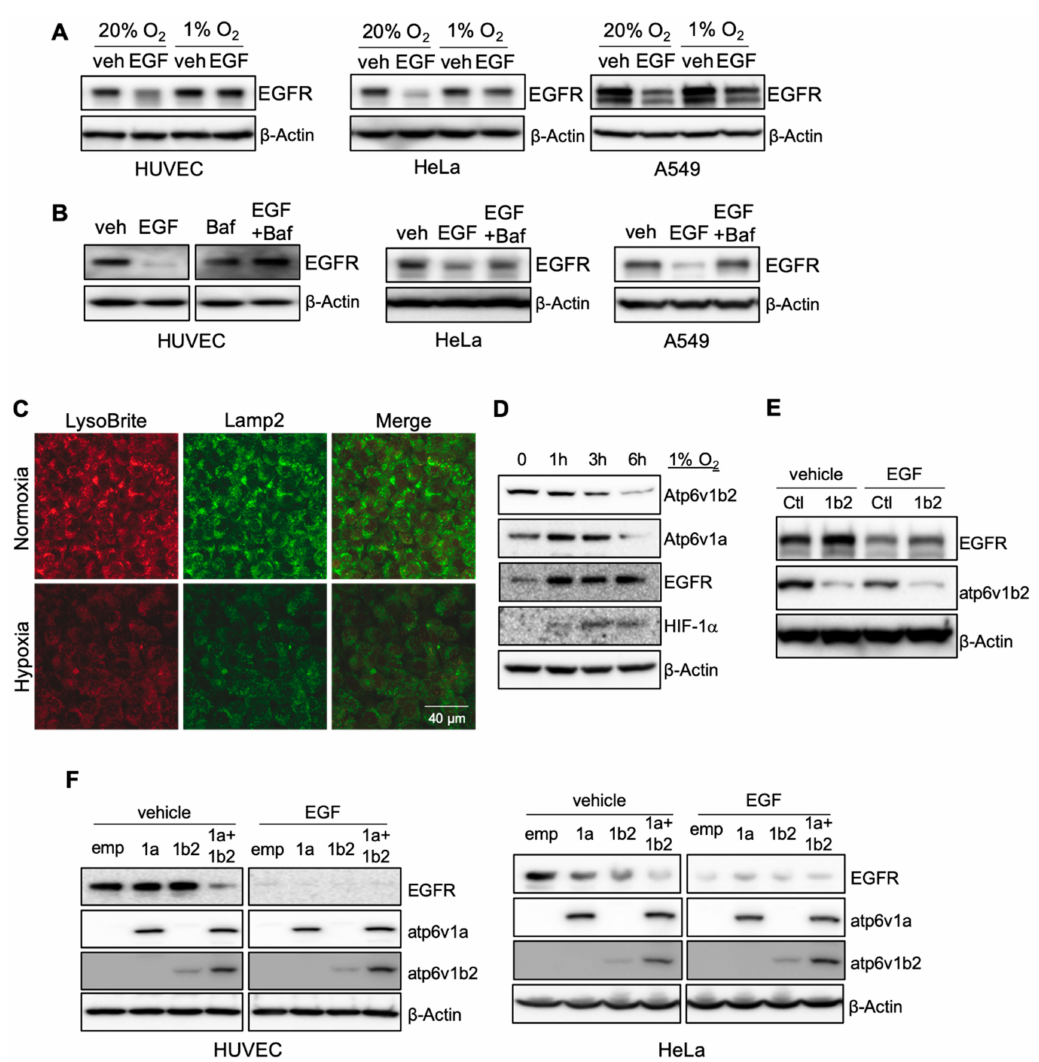
Figure 1. Hypoxia inhibits lysosomal activity via suppression of V-ATPase expression. HUVECs, HeLa and A549 were serum-starved overnight, followed by stimulation with 50 ng / mL of epidermal growth factor (EGF) under 20% or 1% oxygen conditions for 5 h. Cell lysates were used to measure epidermal growth factor receptor (EGFR) levels by Western blot ( A ). Serum starved cells were treated with 50 ng / mL of EGF in the presence or absence of 100 nM of Bafilomycin A1 for 5 h, followed by Western blot for EGFR ( B ). HUVECs were incubated in either 20% or 1% O 2 in the presence of LysoBrite-NIR for 4 h. Cells were fixed and immunostained for Lamp2 ( C ). Images were collected from confocal microscopy. Representative images are shown. HUVECs were cultured in 1% O 2 for the indicated times, followed by Western blot ( D ). HUVECs were infected with ATP6V1B2 shRNA lentiviral or control vectors ( E ), or infected with lentiviral vectors for ATP6V1A and / or ATP6V1B2, for 2 days ( F ). The cells were serum-starved overnight followed by stimulation with 50 ng / mL of EGF for 5 h. Figure S5 shows the raw data for Western blots of Figure